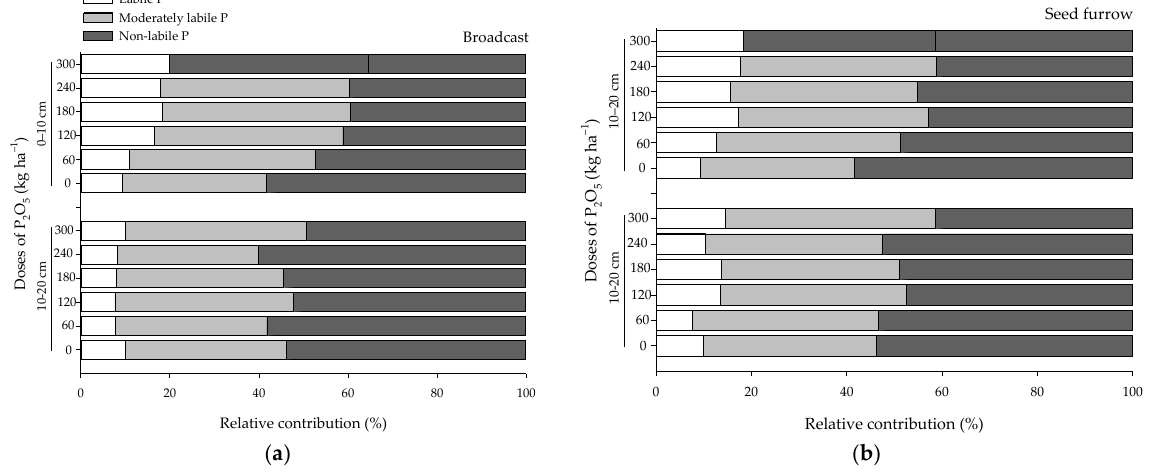
Figure 6. Relative contribution of labile, moderately labile, and non-labile P pools at 0–10 and 10–20 cm soil layers after six years of annual phosphate doses application at ( a ) broadcast and ( b ) seed furrow. Thus, there is evidence that higher annual P doses resulted in more labile P fractions after six years due to the progressive saturation of the soil adsorption P sites, reducing the adsorption energy and, consequently, increasing the potential P desorption and its availability over the years [36]. Increasing the soil available P to adequate levels will promote better crop grain yield and consequently improve P use efficiency, which will push for rational use of P fertilizers for the coming cropping seasons, making this non- renewable resource more sustainable for our next generations. The adequate phosphate fertilizer management is essential for improving the grain yield in new Cerrado areas. In this context, the importance of corrective P fertilization for obtaining higher grain yield and promoting adequate levels of labile P accumulation in the soil was evidenced, with rational doses promoting promising yield results. Otherwise, if the farmers are not aware of soil P buildup, there should be necessary high doses of annual P fertilizer application, being the most effective for grain yield. In this case, it was nearly 250 kg ha −1 of P 2 O 5 . 4. Conclusions Phosphate fertilizer management has a direct influence on crop yields in new Cerrado areas. The best management observed so far is the corrective phosphate fertilization incorporated at 0–20 cm and the maintenance P at seed furrow, presenting the highest crop yield and more labile P in the soil. Relative to crop responses on P fertilizer doses, when higher annual P doses were used during the first three years of cultivation the grain yield was substantially improved, with a maximum crop response of about 250 kg ha −1 of P 2 O 5 , irrespective of application mode, which also expressively improved the soil labile P fractions. Soil P dynamics are complex in tropical regions, and understanding the adequate P fertilizer dose/source management is essential in expansion areas of Brazilian Cerrado. Our results show the importance of corrective phosphate fertilization for higher crop yield. In addition, when corrective P fertilization is performed, the application mode has little relevance in crop yield. These results provide an essential reference for orientating P management decisions in sustainable agricultural systems. The application of high doses of P results in high P accumulation in the soil (called legacy P). Future research should evaluate the use of different plant species for recycling this legacy P accumulated over the years, reducing the dependance on external P inputs.